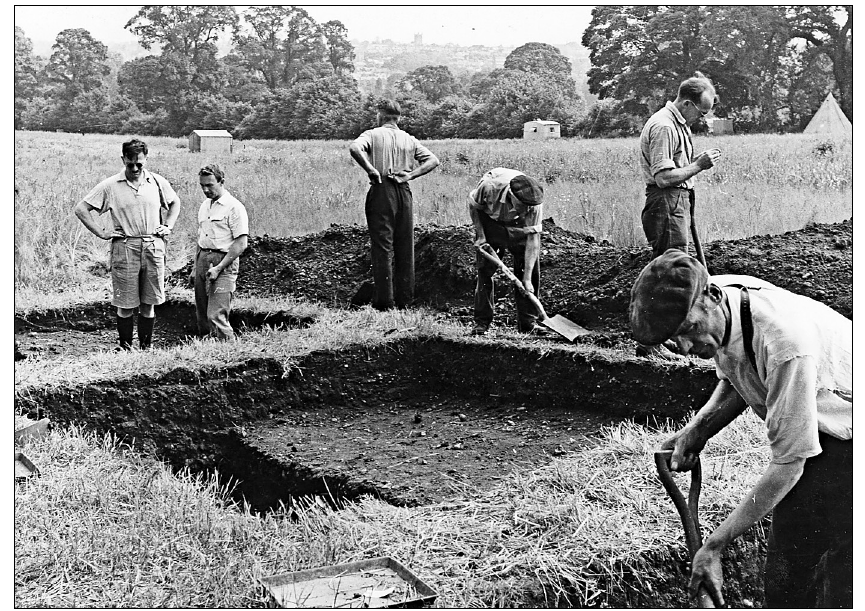
Figure 4 Paid labourers at Verulamium in 1955; Sheppard Frere at extreme left; the elderly man (front right) had worked for Wheeler (Fig. 5) at Verulamium in 1930–34.